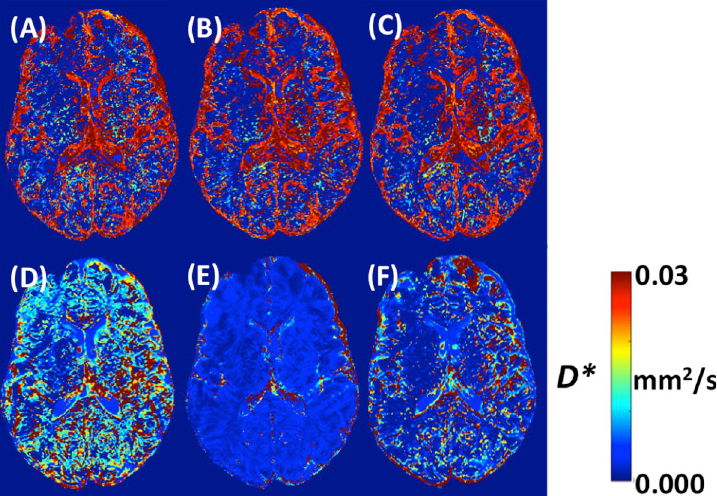
Fig 4. Example of IVIM D � parameter maps with acquisition schemes found best according to their standard deviation for gray and white matter. b values (number of averages) (A) 3 min (0 (5), 200 (5), 900 (5) s/mm 2 ), (B) 6